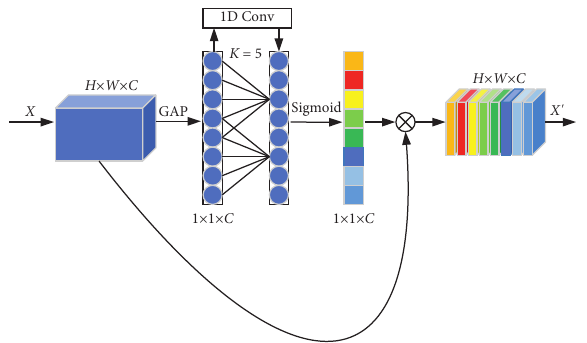
Figure 6: Structure diagram of the efficient channel attention